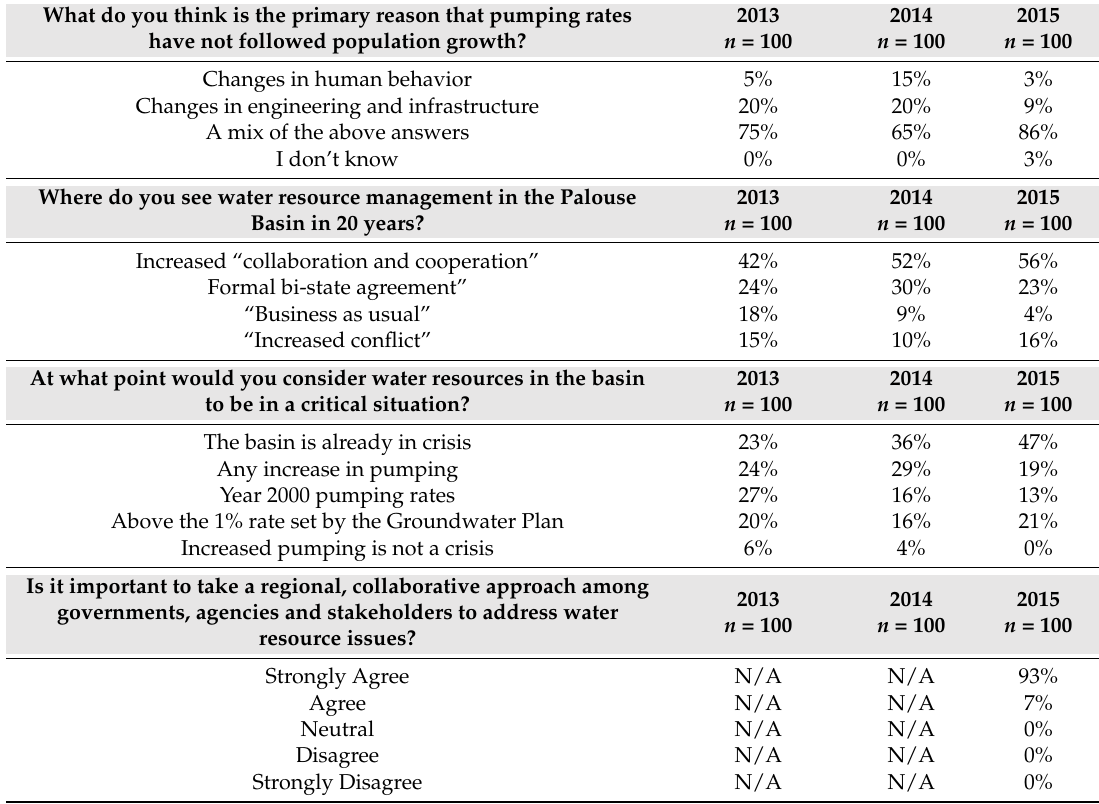
Table 4. Partial list of responses to clicker questions presented to participants at the Palouse Basin Water Summit (for additional questions please contact